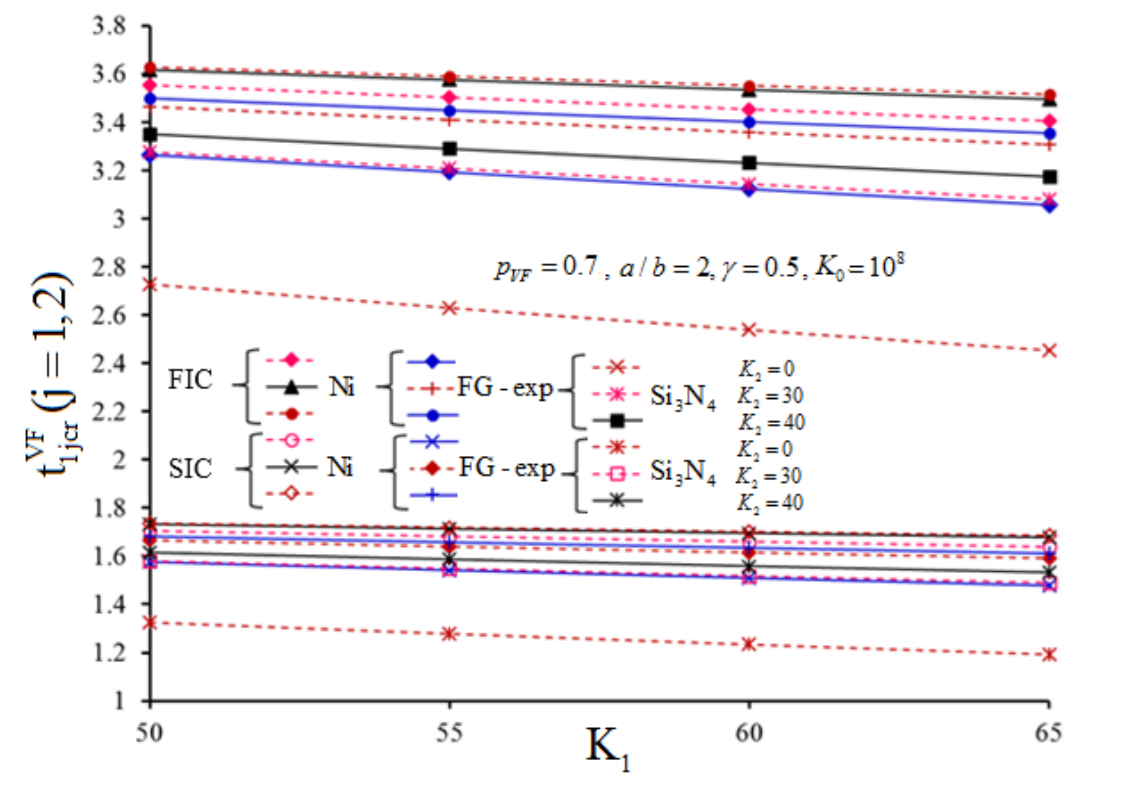
K with FIC and SIC for Figure 5. Changes of critical times of FG-VE-Ps on VE-Fs depending on Figure 5. Changes of critical times of FG-VE-Ps on VE-Fs depending on K 1 with FIC and SIC for 1 K . different different K 2 . 2 K i = ) The changes of critical times of FG-VE-Ps on VE-Fs (with various ( 0,1,2) i against / ah for FIC and SIC are shown in Figure 6. The critical times of FG-VE-Ps for various FIC and SIC decrease as / ah increases. The data for the numerical analysis are: 0 . 7 , 0 . 5 VF a / b = 2 , p  == and ( 0 , 1 , 2 ) K i = , as shown in Figure 6. With increasing / ah i ratio, the influence of the VE-F (for 7 4 . 510 , 0 KKK === ) on the values of the critical 012 time increases, while the effect of the VE-F (for 7 4 . 510 , 40 , 0 KKK === ) on the critical 012 time is significantly greater than the effect of the previous VE-F type, although the influ- ence of the VE-F is quickly decreasing. In addition, it is found that the influence of the VE- F (for 7 = ) on the critical time is smaller than the previous VE-F, 0 and this effect also decreases with increasing / a h . Note that the effects of the FG profile on the critical time decrease for all soil types as / ah increases.